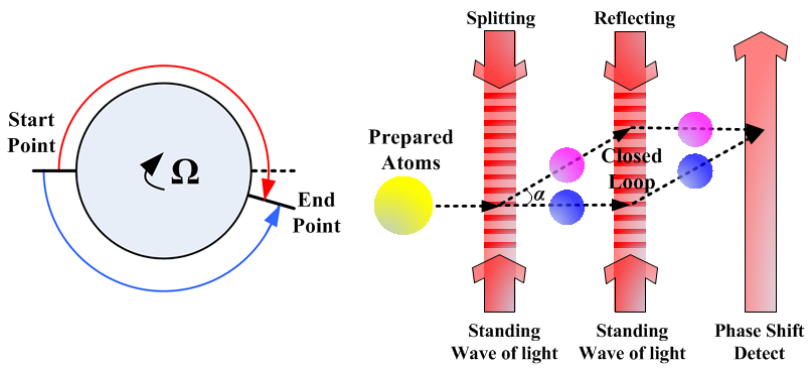
Figure 1. Principle of